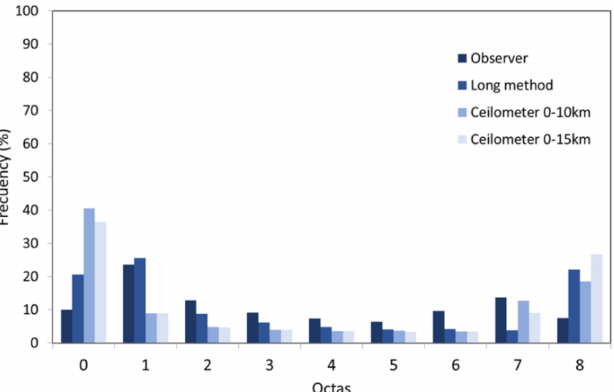
Figure 2. Frequency of total cloud amount as registered by meteorological observers and derived from the Long and ceilometer